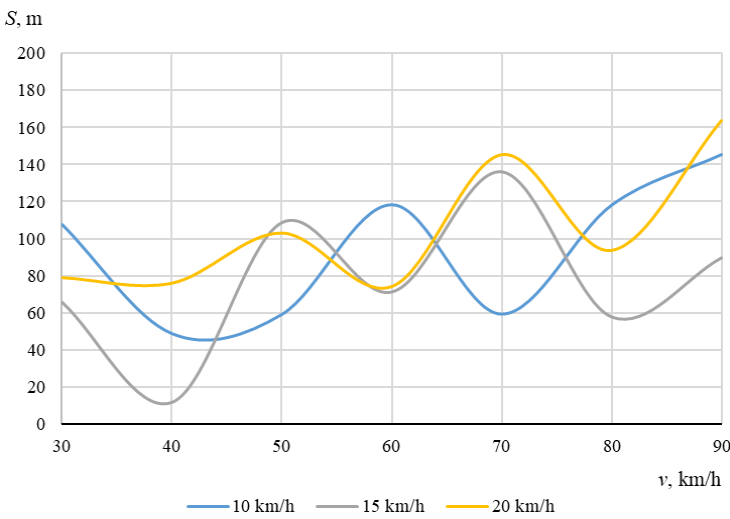
Figure 14. Throwing distances of the bicycle (impact angle 60°).